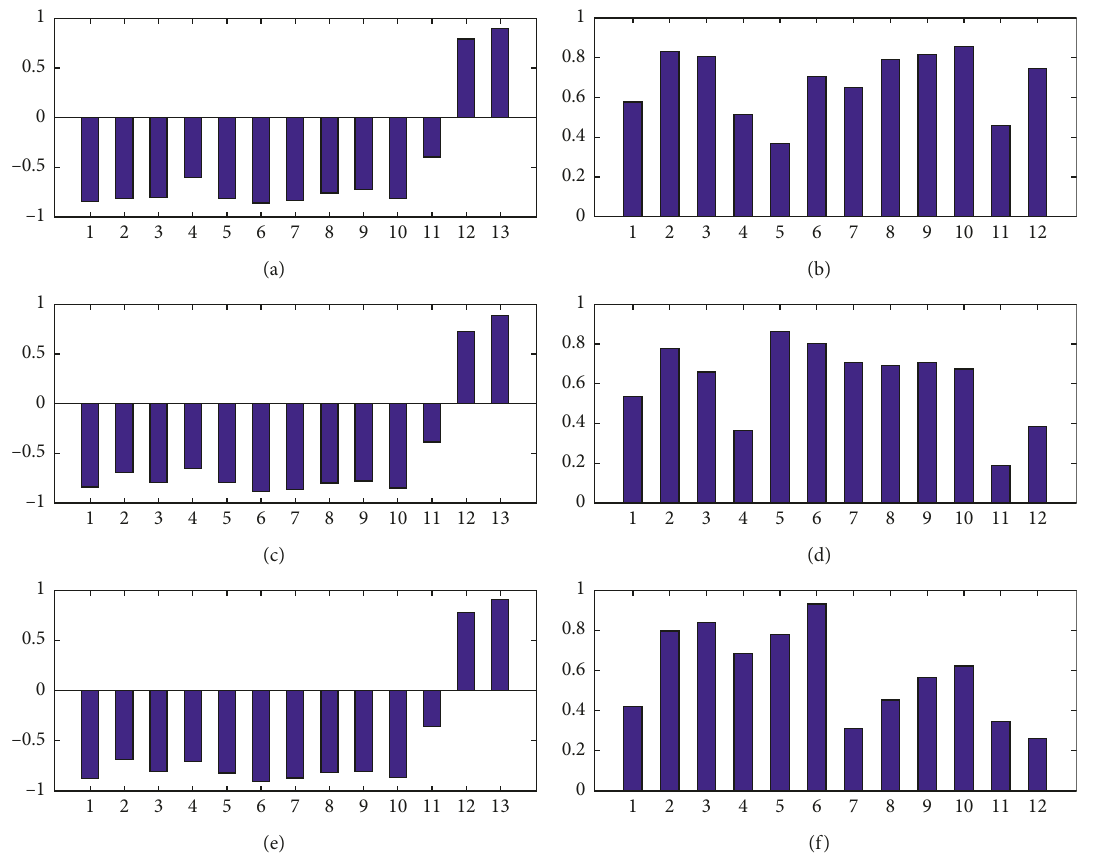
Figure 12: (a) Left heterogeneous correlation coefficients of the Arctic vortex indices (1–13) and the probability of surface ducts. (b) Right heterogeneous correlation coefficients of the Arctic vortex indices and the probability of surface ducts. (c) Left heterogeneous correlation coefficients and (d) right heterogeneous correlation coefficients of the Arctic vortex indices and the intensity of surface ducts. (e) Left heterogeneous correlation coefficients and (f) right heterogeneous correlation coefficients of the Arctic vortex indices and the thickness of surface